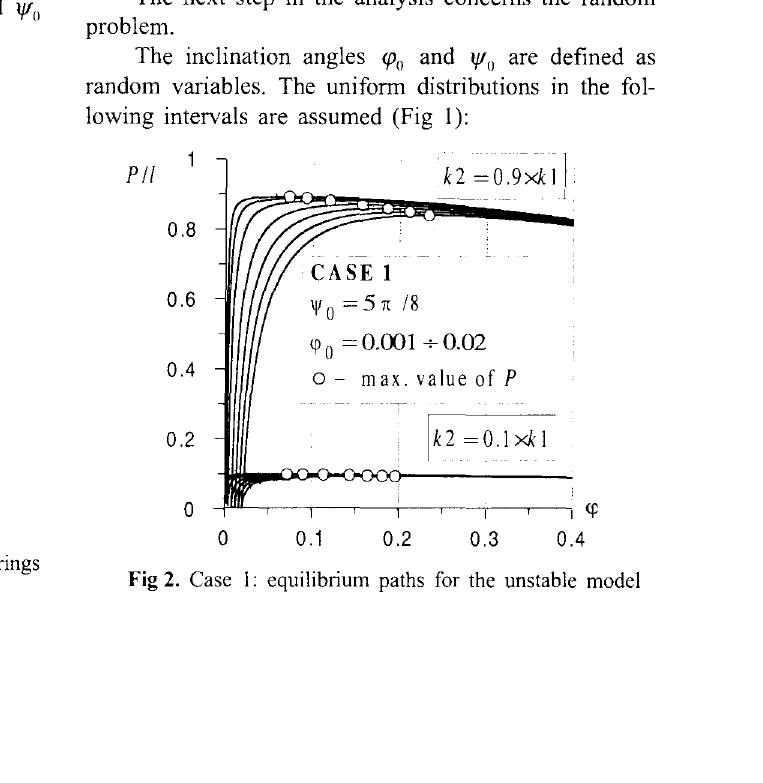
Fig 2. Case I: equilibrium paths for the unstable